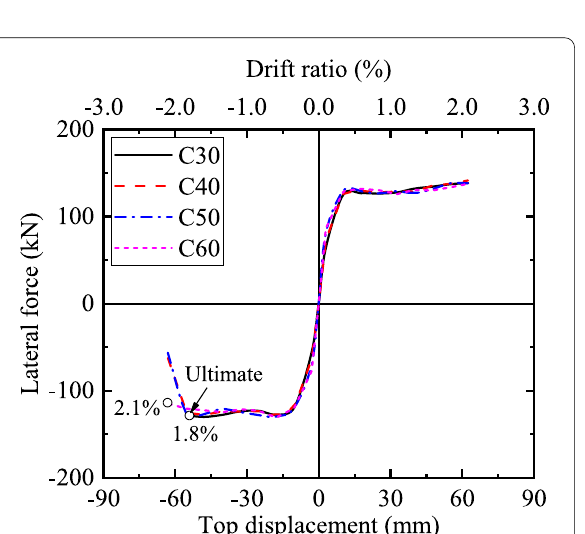
Fig. 22 Skeleton curves of specimens with different concrete cube compressive strength.